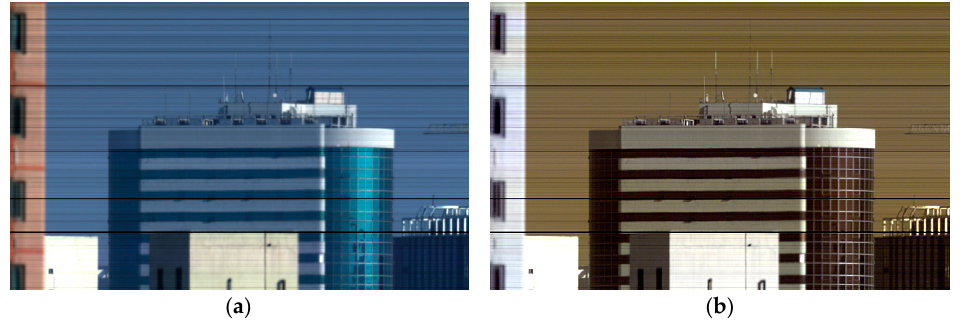
Figure 5. RGB image in visible bands from Camera 1 (R: 650 nm, G: 560 nm, B: 480 nm). Remote Sens. 2018 , 10 , 79